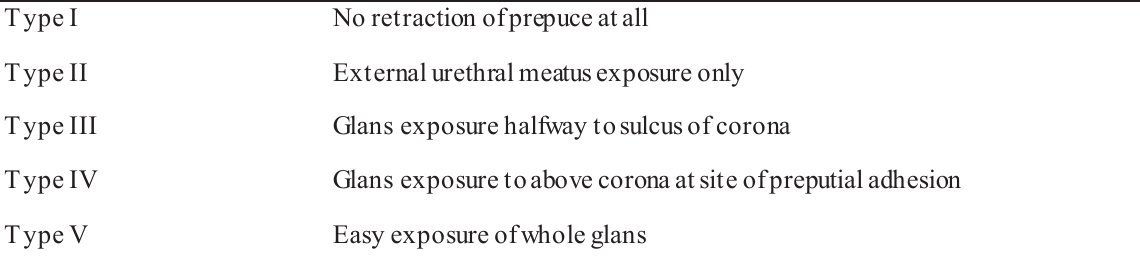
Table 2 - Classification of prepuce type showing presence or absence of tight ring